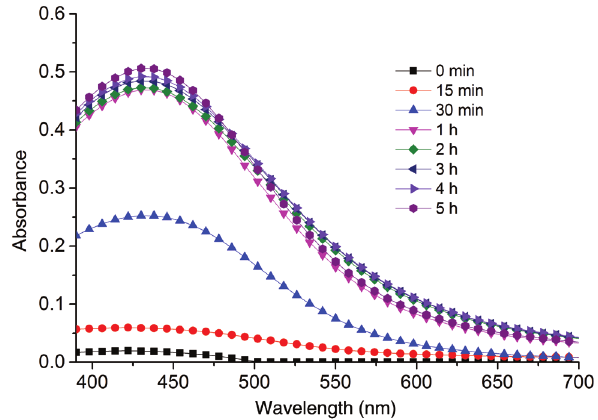
Figure 2: Effect of contact time on AgNPs